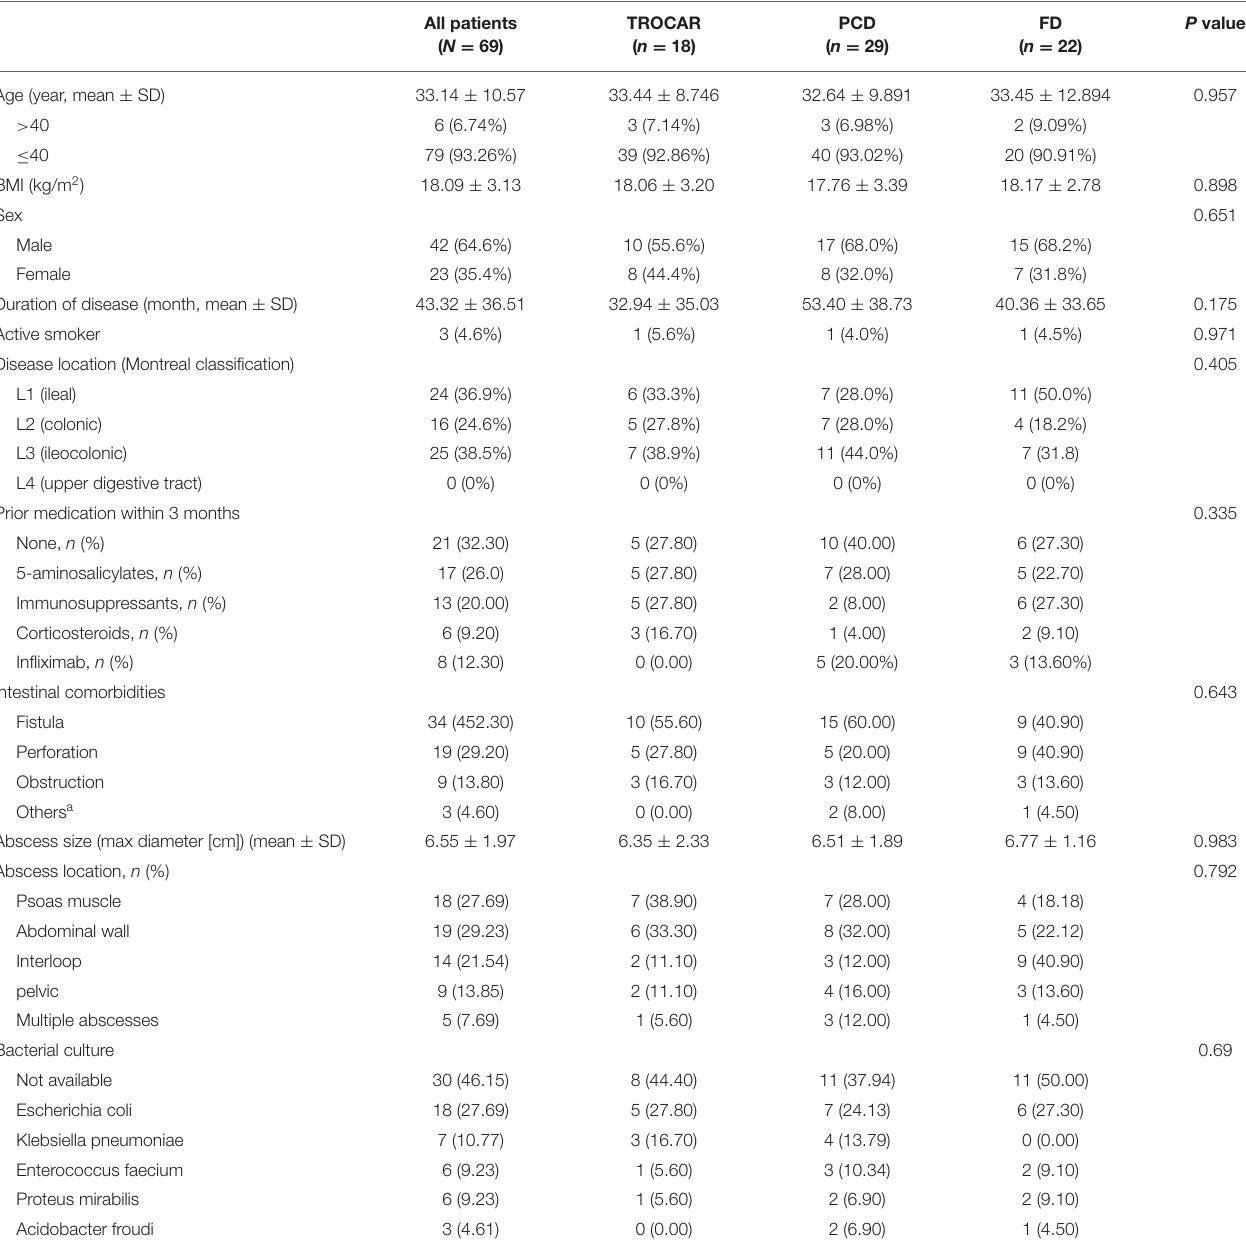
TABLE 1 | Baseline characteristics of patients with abdominal abscess.